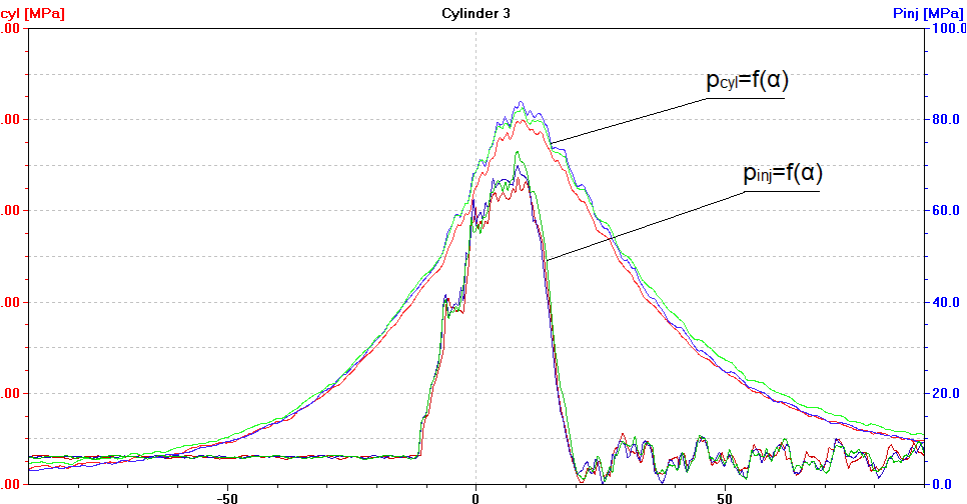
Figure 5. The diagram (screenshot of Unitest 2008) illustrates the p cyl = f( α ) function with fuel injection characteristics of p inj = f( α ) for a diesel–electric unit (DEU) with a defect-free/healthy ship engine loaded at 70% of MCR. Waveforms for cylinder: — No. 1, — No. 2, — No. 3.